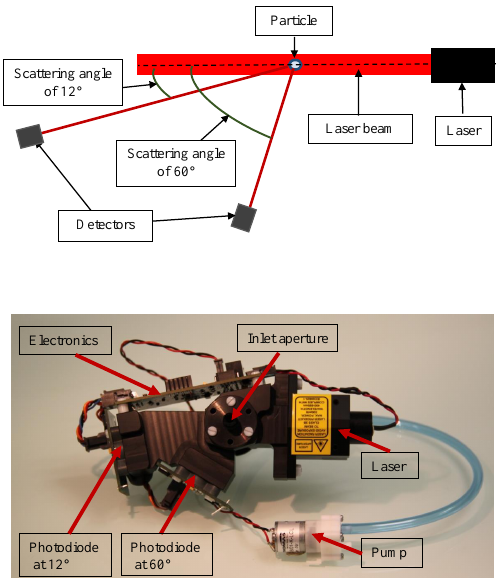
Figure 2. The LOAC instrument; upper panel: principle of mea- surement; lower panel: picture of the instrument (the inlet tube is not presented here).